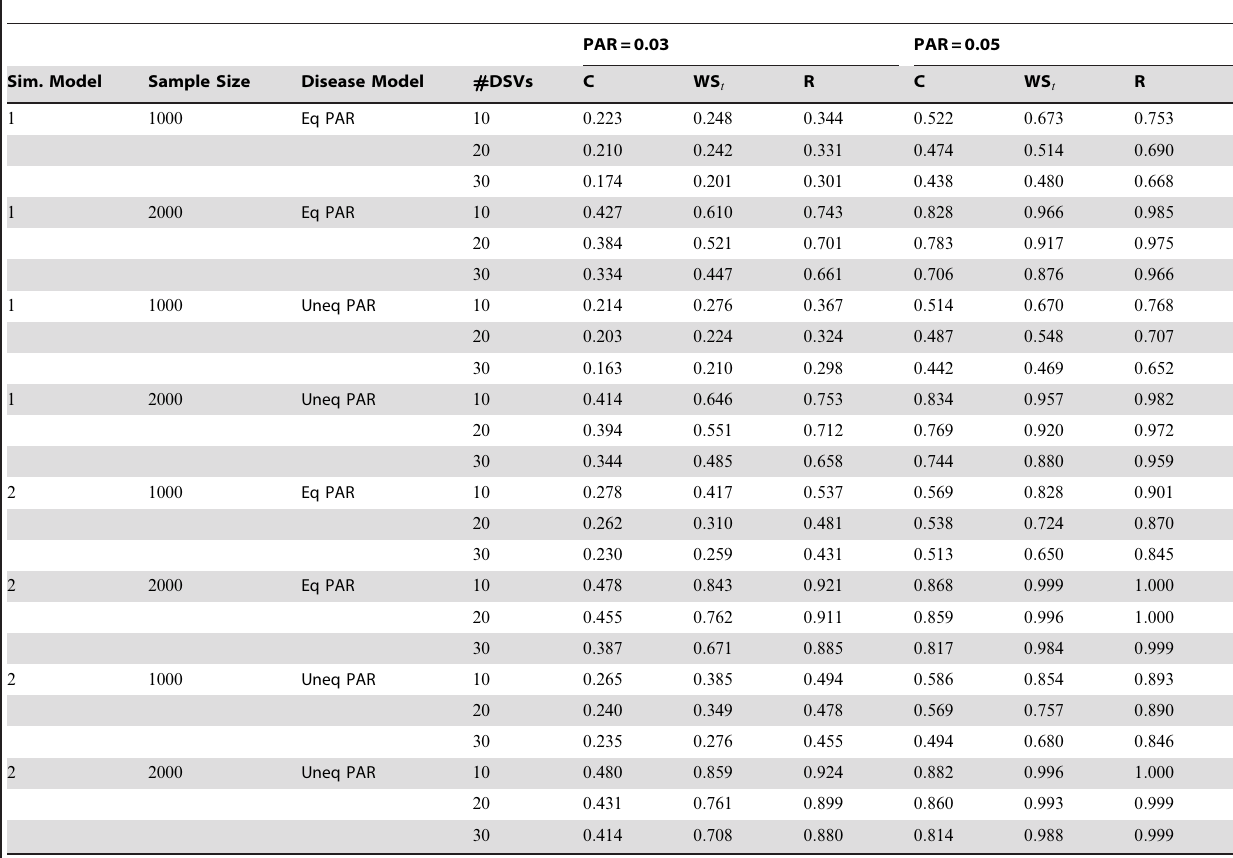
Two genetic simulation models are assumed: neutral variants (1), and mildly deleterious variants (2). Varying number of DSVs are assumed, that can contribute equally or unequally to the total PAR. The sample size is the total number of individuals sequenced, with equal numbers of cases and controls. All tests are two-sided, i.e., testing for the presence of risk or protective variants in the region of interest.